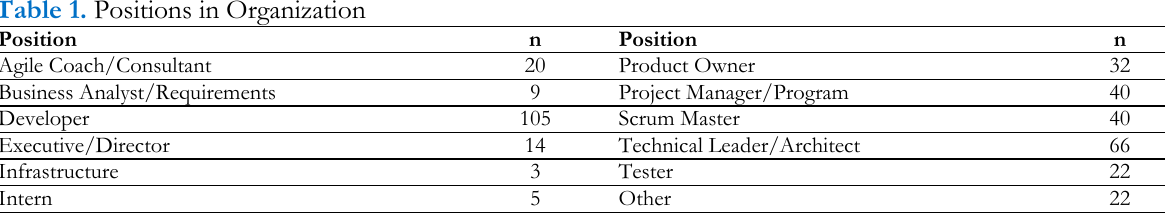
Table 1. Positions in Organization